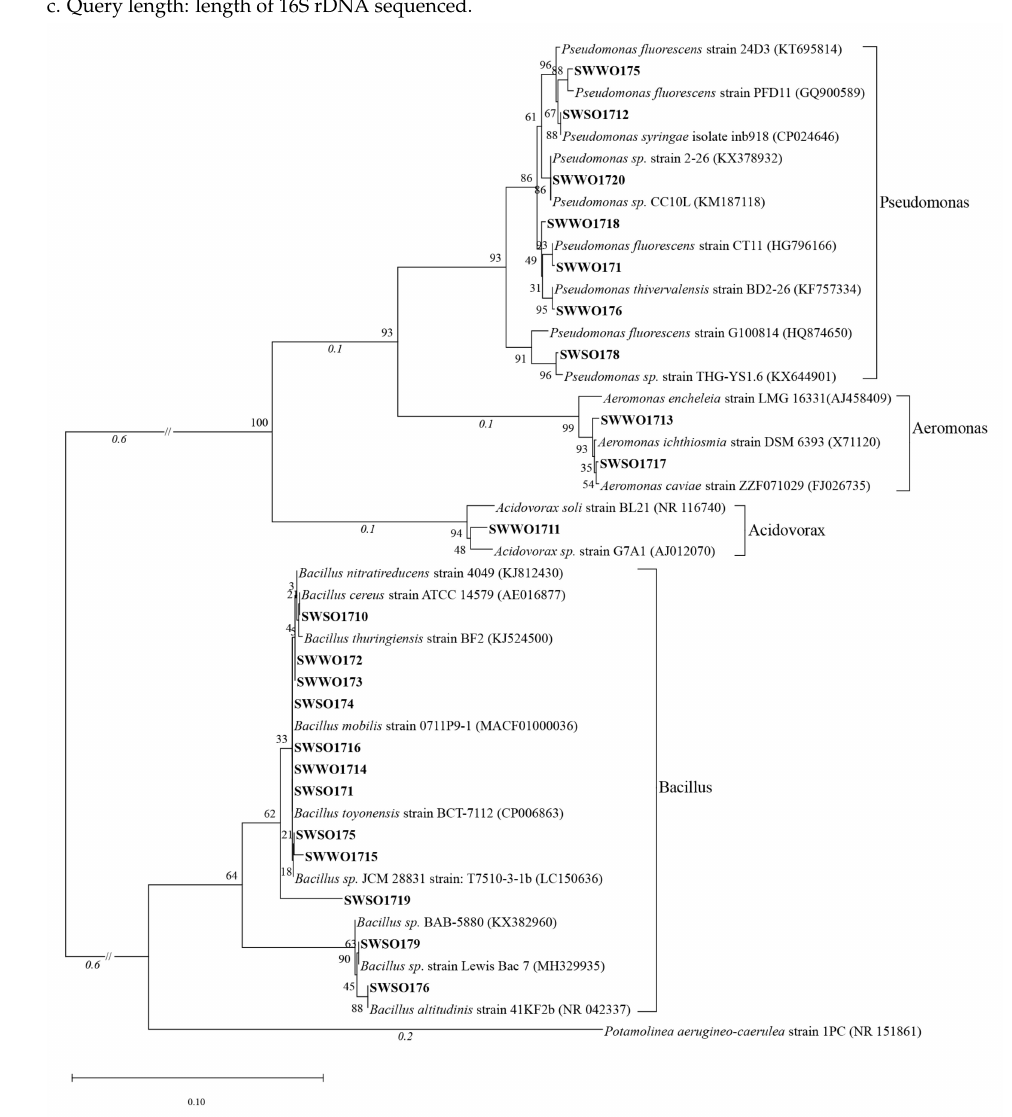
Figure 2. A neighbor-joining tree showing the phylogenetic relationships among 16S rDNA sequences of isolated OPB strains and their closely related sequences from EzBioCloud. The numbers at the nodes indicate the bootstrap values based on the neighbor-joining analyses of 1000 resampled datasets. The scale bar indicates evolutionary